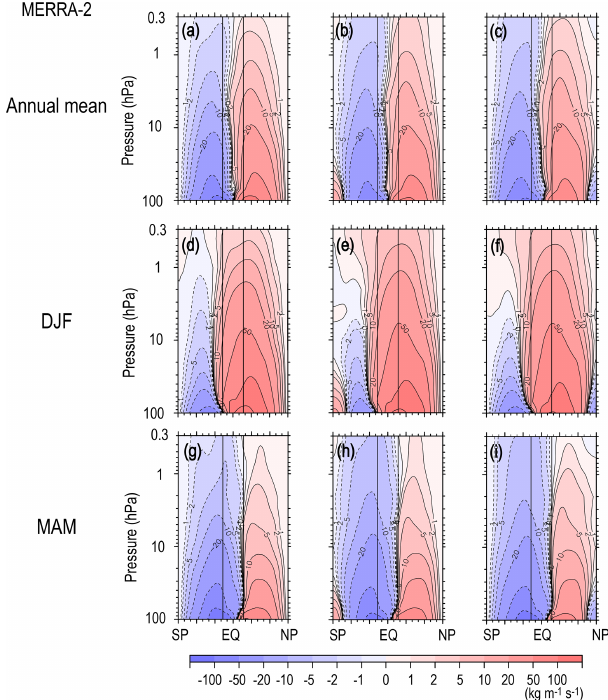
Figure A1. Meridional cross sections of the climatology of the an- nual mean, DJF, and MAM stream function of the residual mean flow from the top. (a, d, g) Estimates from the vertical integration of v ∗ . (b, e, h, c, f, i) Estimates from the latitudinal integration of w ∗ starting from the North (South)